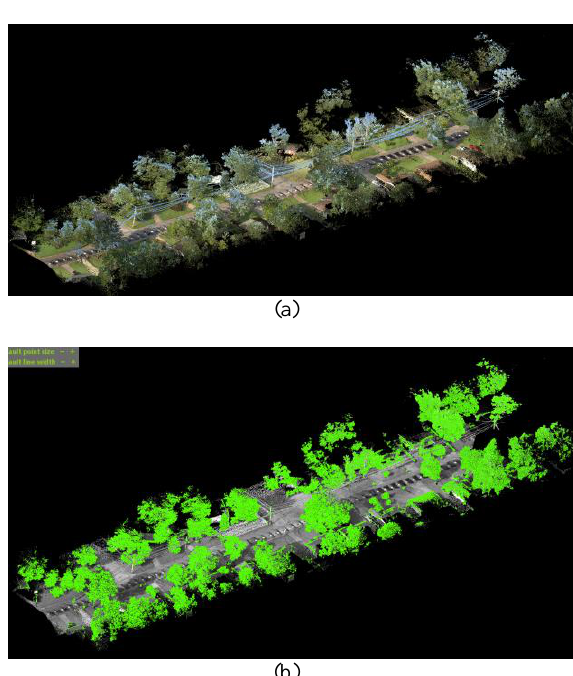
Figure 6. Lidarusa urban dataset; (a) Recorded LiDAR point clouds, (b) Output of the proposed algorithm in tree